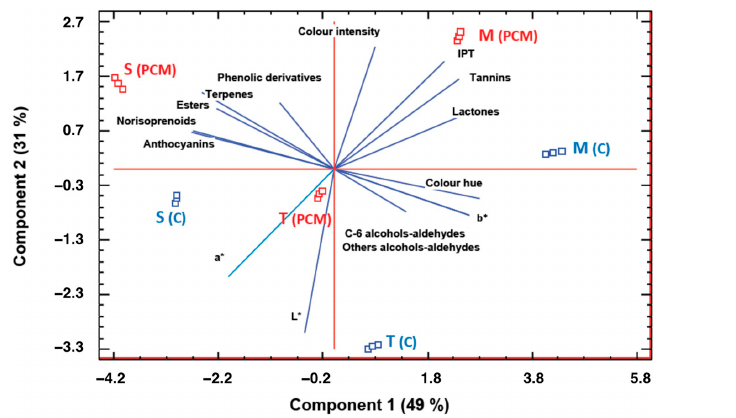
Figure 2. Aromatic series in the wines.